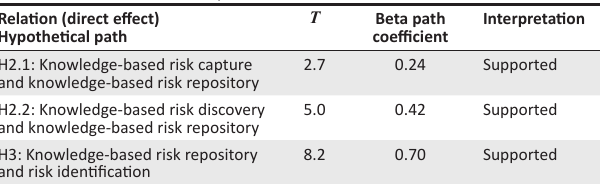
FIGURE 4: Bootstrapping ( T -value) for knowledge-based risk processes on risk identification with mediation of knowledge-based risk repository. TABLE 6: Test results for H2.1, H2.2 and